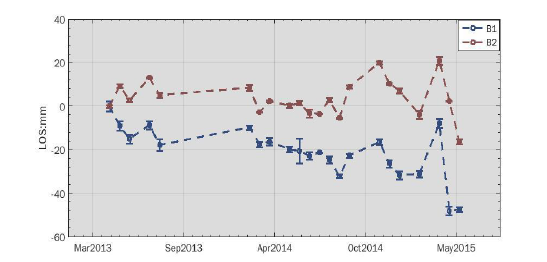
Figure 7. Deformation of a pair of points A1 and A2